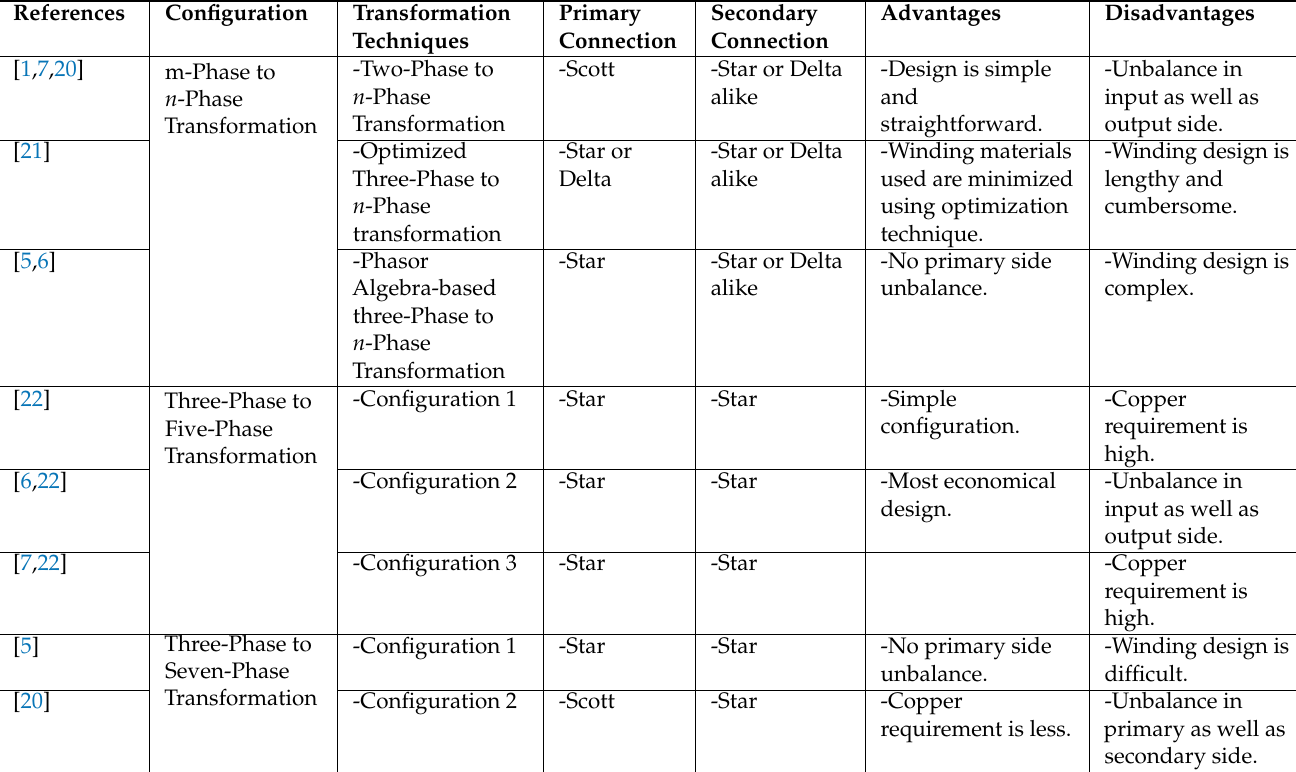
Table 5. Configuration of various transformation techniques for multi-phase